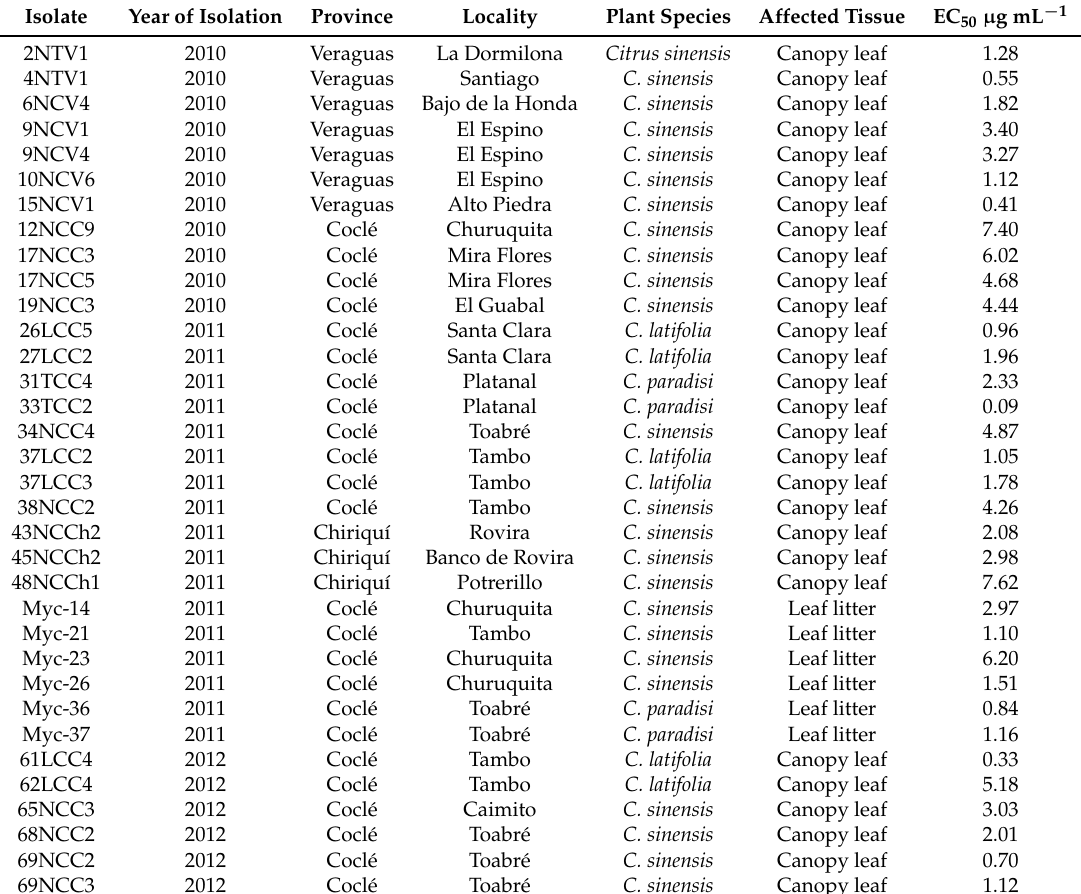
Table 1. Isolates of Zasmidium citri-griseum included in the sensitivity study for fenbuconazole with their corresponding values of the effective concentration needed to reduce mycelial growth by 50% (EC 50 ).